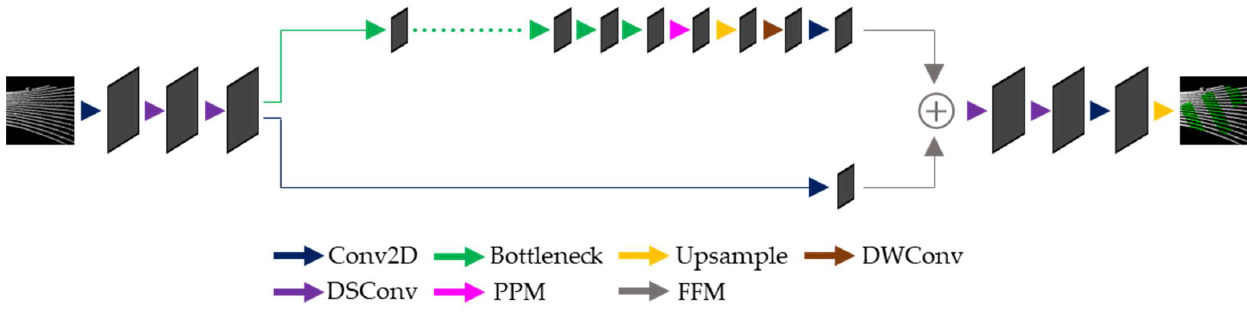
Figure 7. Fast-SCNN structure.